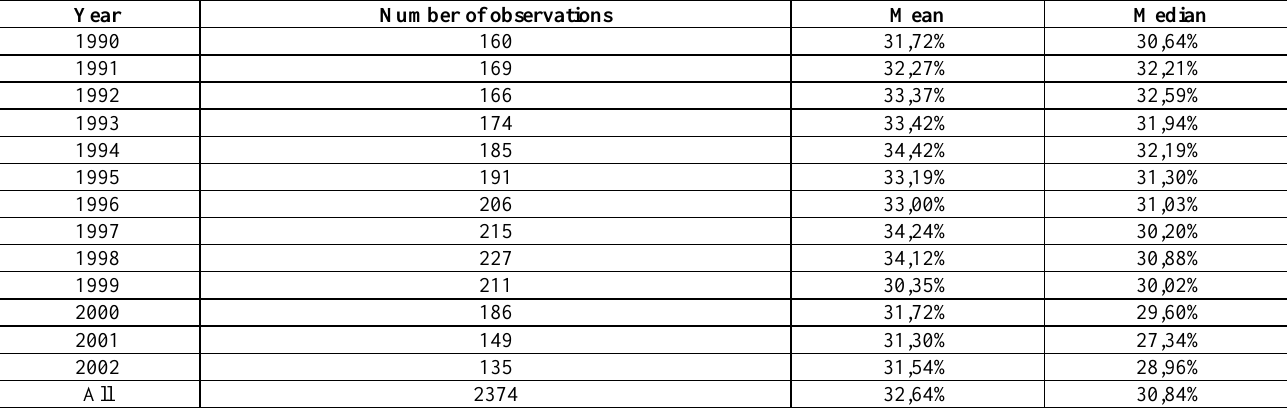
Table 3: Descriptive statistics of VA/sales from 1990 to 2002 – full sample